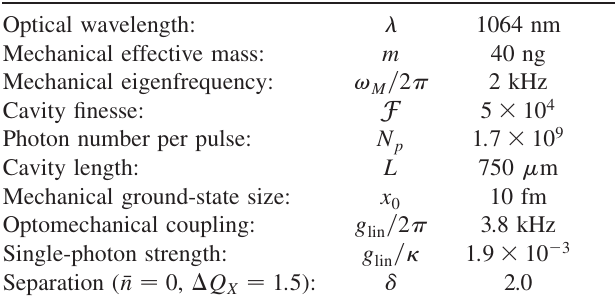
SELECTIVE LINEAR OR QUADRATIC OPTOMECHANICAL . . TABLE I. An experimentally accessible set of parameters to achieve unity square-displacement measurement strength.